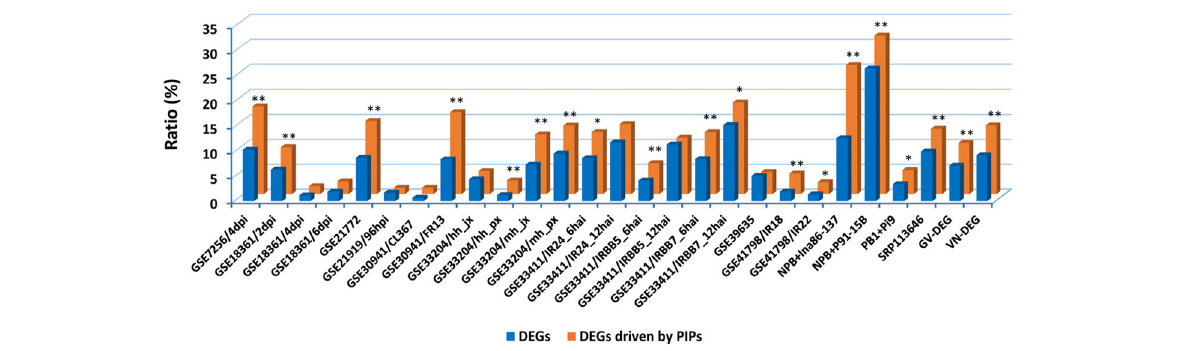
Fig. 5 The enrichment analysis of the differentially expressed rice genes driven by PIPs. * P < 0.05, ** P < 0.01 by post hoc Fisher ’ s exact test comparing each pair of data. The numbers of total reference genes were listed in Additional file/Table S10. DEGs differentially expressed genes